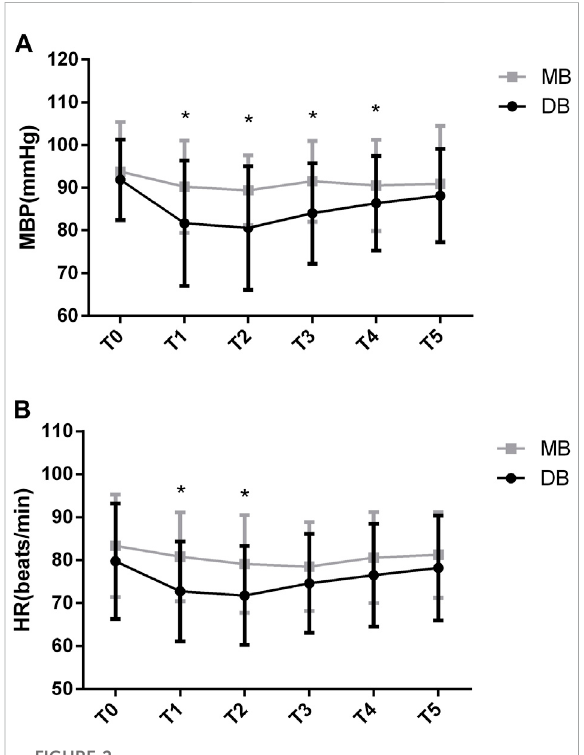
FIGURE 2 MBP and HR values of the two groups. Abbreviation: DB, dexmedetomidine- butorphanol; MB, midazolam-butorphanol; T0: baseline, T1: beginning, T2: 5 min, T3: 10 min, T4: 15 min, T5: 20 min. * p < 0.05 compared with the MB group.